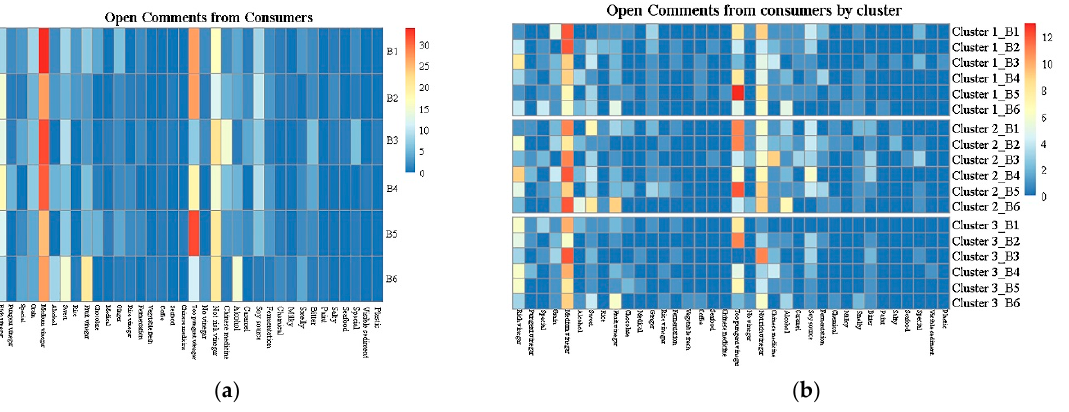
Figure 4. The heatmaps of open comments from all consumers ( a ) and each cluster ( b ). The code of vinegar corresponds with Table 1. The left 18 columns were the terms that consumers liked, and the right 18 columns were the terms that consumers disliked.